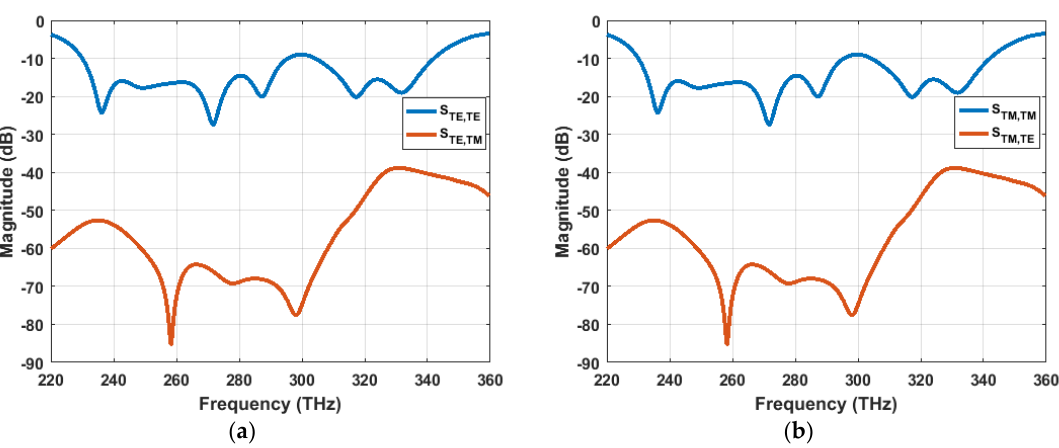
Figure 2. Co-polarization and cross-polarization components of the reflection coefficient (S 11 ) for ( a ) transverse electric (TE)-polarized incident wave and ( b ) transverse magnetic (TM)-polarized incident wave.